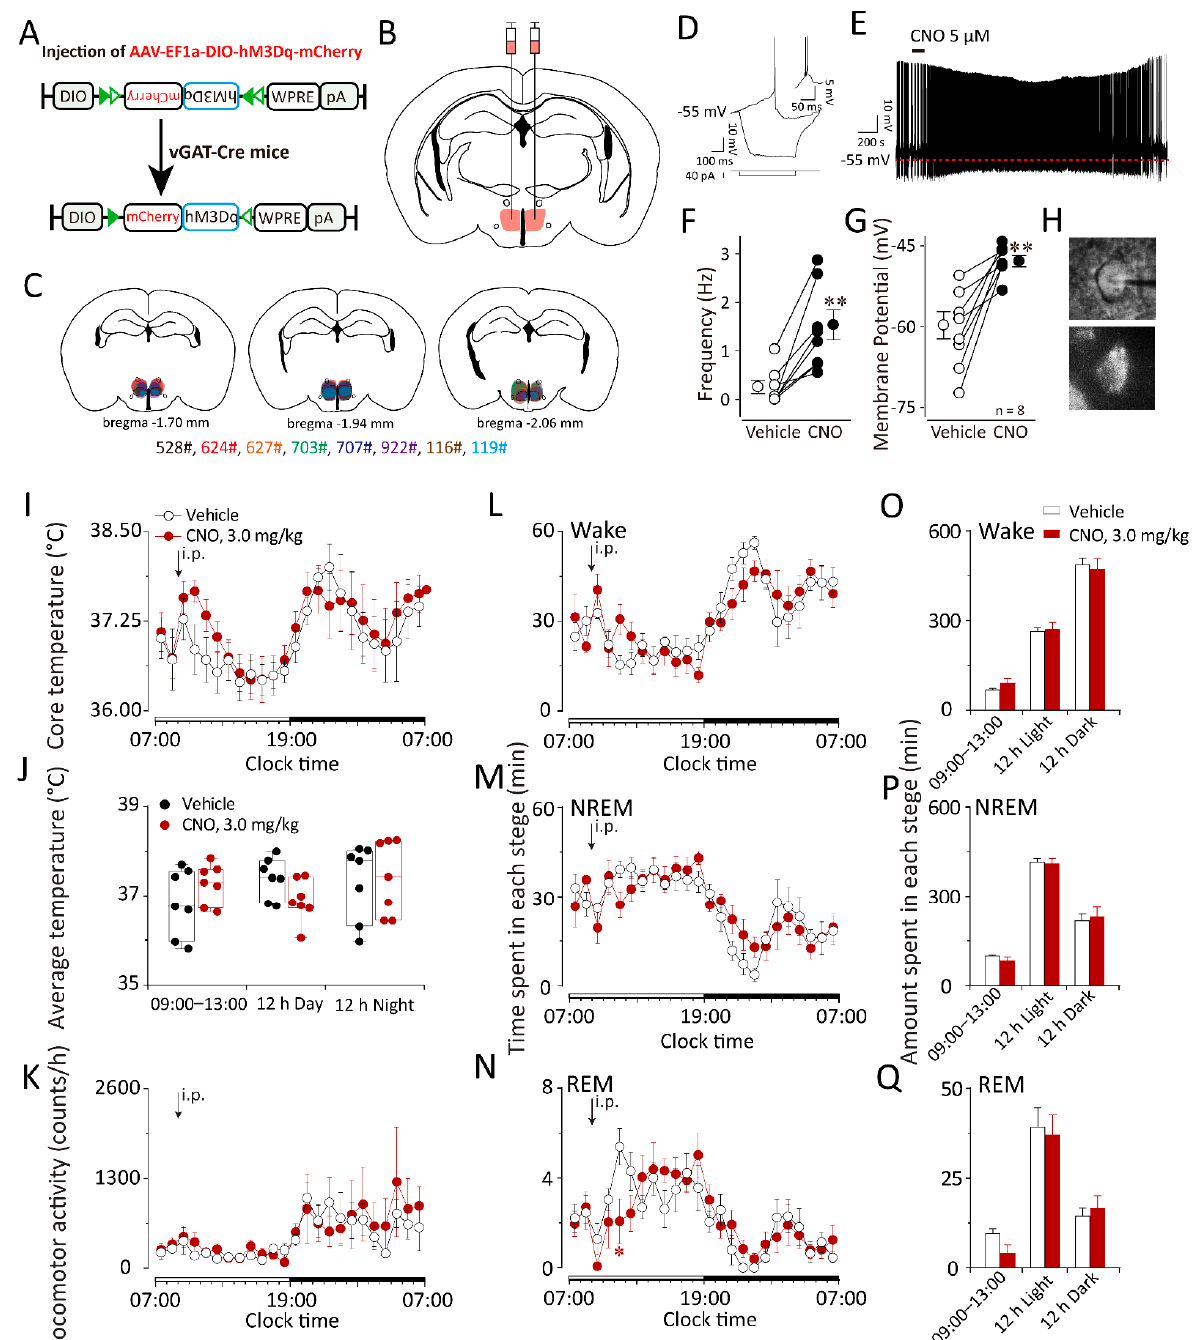
Figure 7. Chemogenetic activation of DMH GABAergic neurons did not affect the core temperature or sleep–wake cycle in vGAT–Cre mice. ( A ) The schematic representation of the microinjection of AAV–DIO–hM3Dq–mCherry into the DMH of vGAT–Cre mice. EF1 α , elongation factor 1–alpha; DIO, double–floxed inverse orientation; hM3Dq, selective human muscarinic acetylcholine M3 receptor; WPRE, woodchuck hepatitis virus post-transcriptional regulatory element; pA, poly(A) tail. ( B , C ) Drawings of superimposed AAV microinjection sites in the DMH of vGAT–Cre mice ( n = 8, indicated with different colors). ( D ) The typical electrophysiological trace showing the whole- cell current clamp recording of a GABAergic neuron expressing hM3Dq–mCherry fusion protein. ( E ) The administration of CNO (5 µ M) elicited the rapid depolarization of the membrane potential and concomitantly increased the frequency of action potential firings. ( F ) The frequency of action